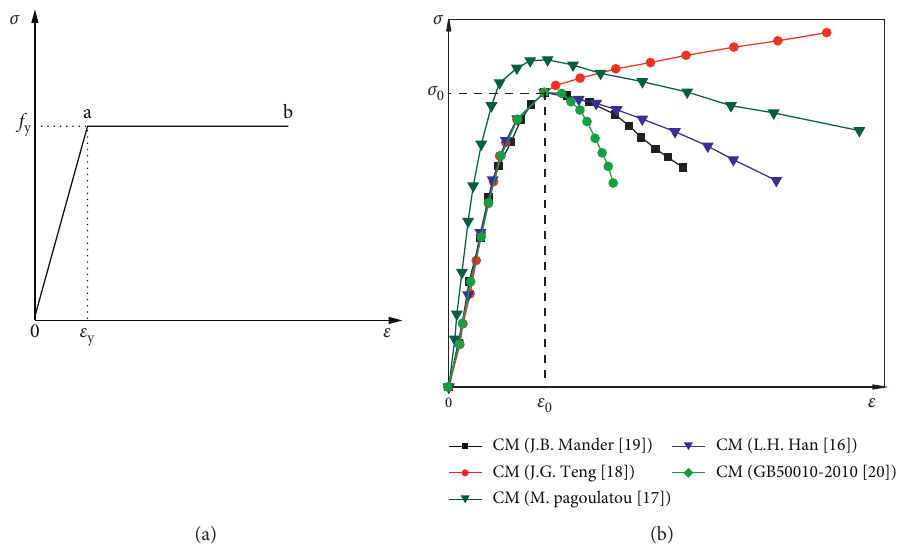
Figure 2: Constitutive models. (a) Constitutive model of steel. (b) Constitutive models of concrete.